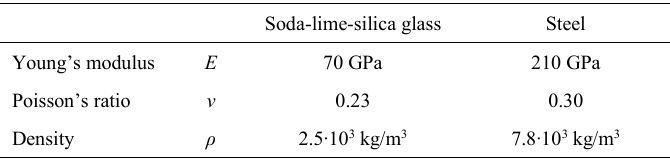
Table 3: Basic material properties used in the ring-on-ring simulations.